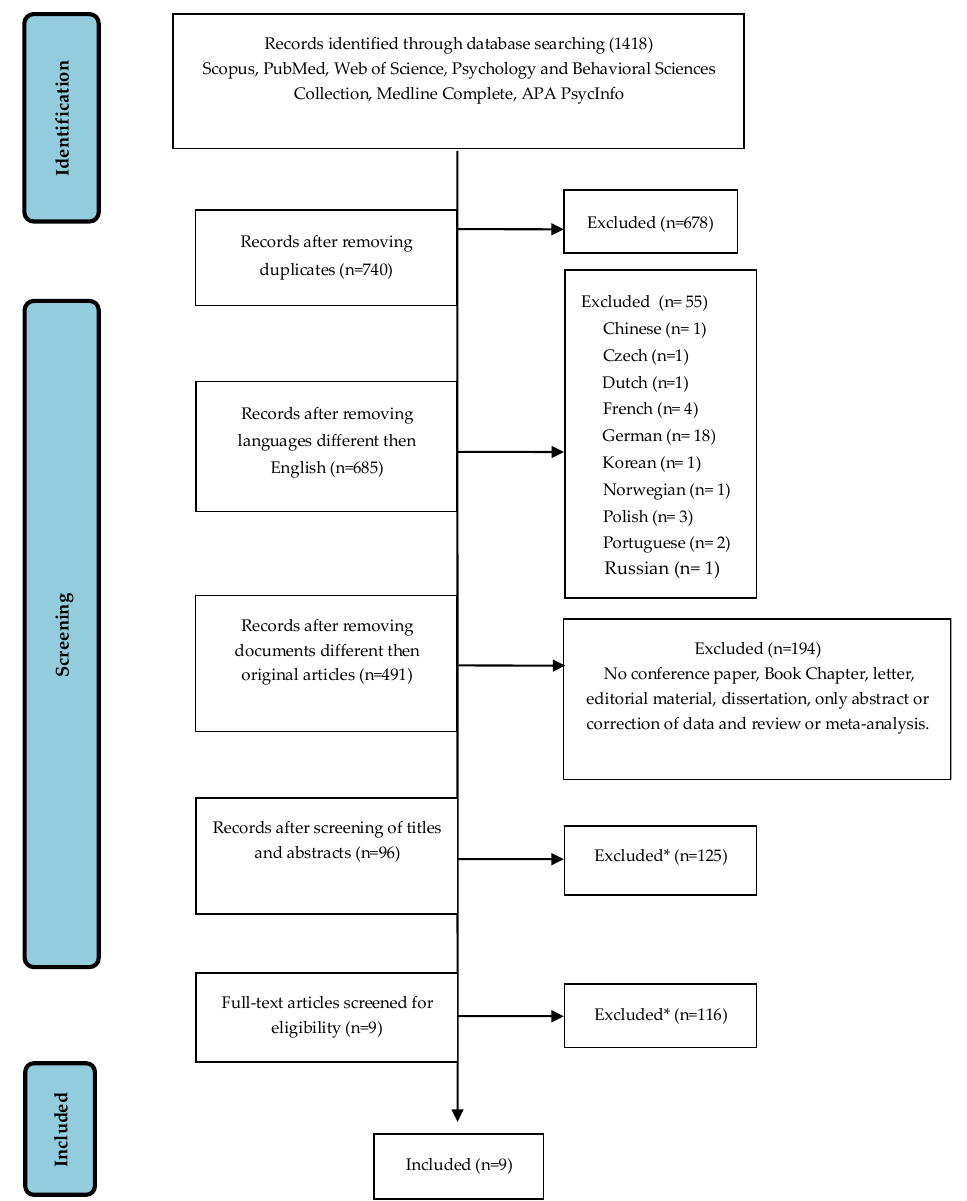
Figure 1. PRISMA flow diagram of the selection process. * Studies not complying with the eligibility criteria were excluded.